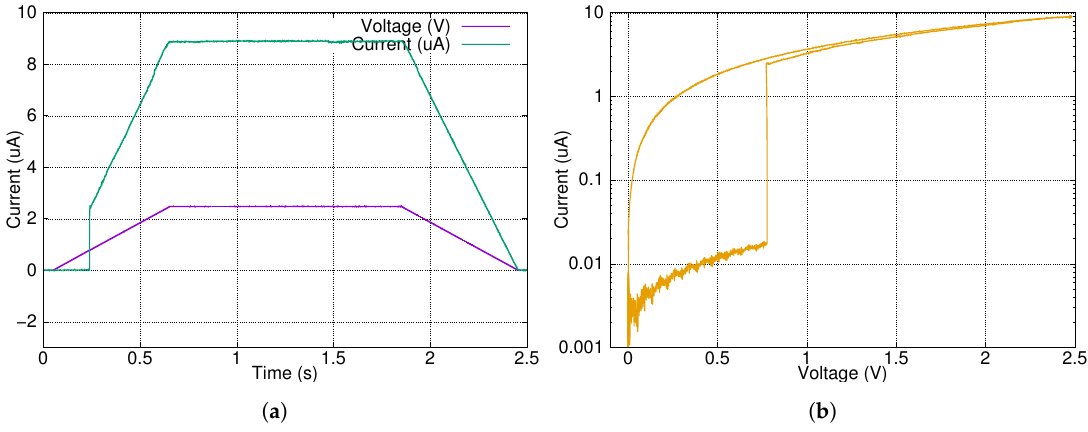
Figure 4. Long timescale measurement on a single memristor device with focus on the writing characteristics. ( a ) The input signal and output response in the time domain. ( b ) Phase portrait of the measurement. Switching is very sharp and the ON/OFF ratio is at least 100.